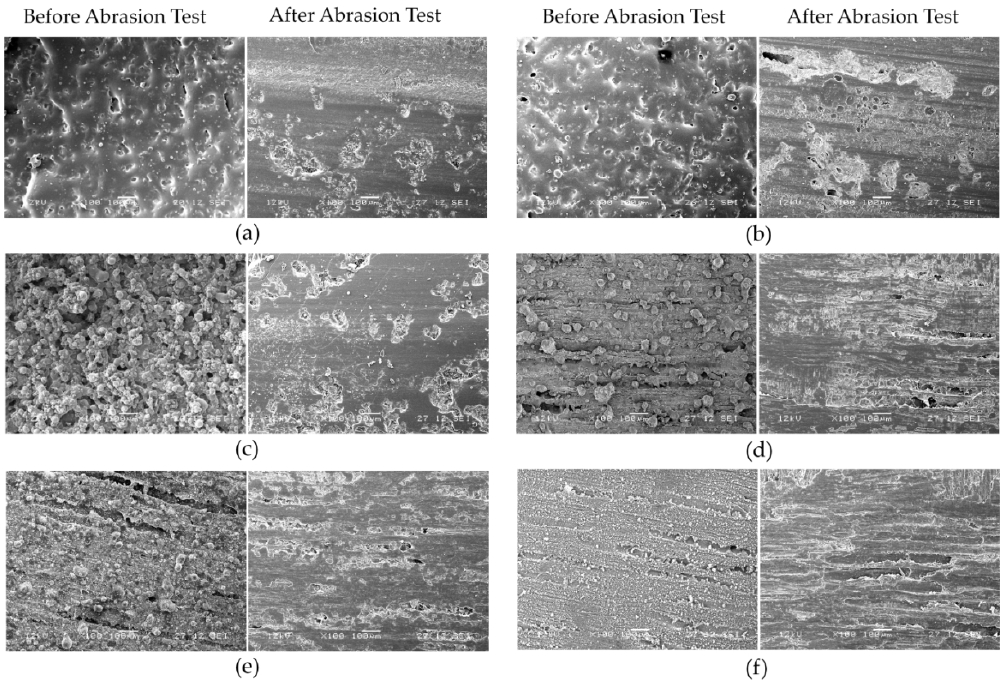
Figure 8. SEM images at magnification of 100× (scale bar 100 μ m) of coatings on wood substrates before and after abrasion test. ( a ) polyester thick film; ( b ) polyester thin film; ( c ) polyester / TiO 2 thick film ( d ) polyester/TiO 2 thin film; ( e ) polyester/TiO 2 thin film via (PSP); ( f ) TiO 2 film.